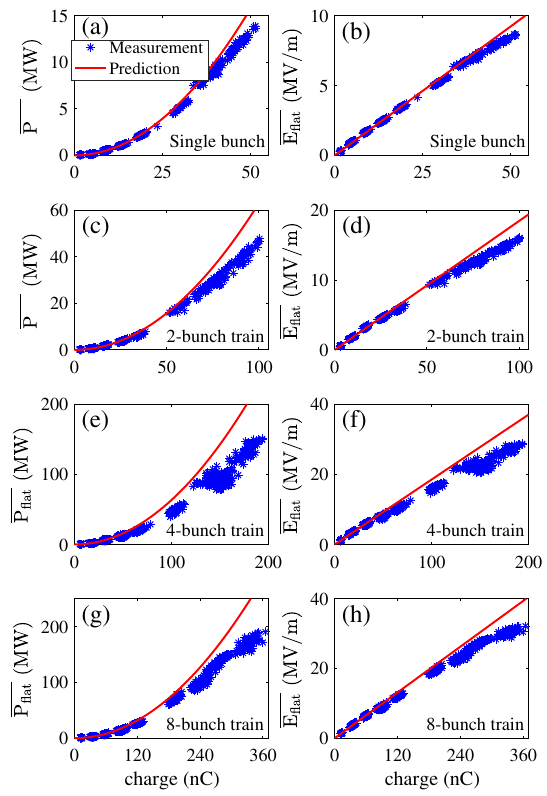
FIG. 15. Comparison of the rf power (left) and the wakefield gradient (right) of the flat-top between the experimental result and the theoretical prediction. In the experimental results, the rf power is the measurement data and the wakefield gradient is the derived value by Eq. (19) based on the uniform section param- eters listed in Table I. In the prediction, the form factor is fixed at 0.96; the quality factor of the uniform section is set to 950 according to the cold-test results; and the realistic charge balance is